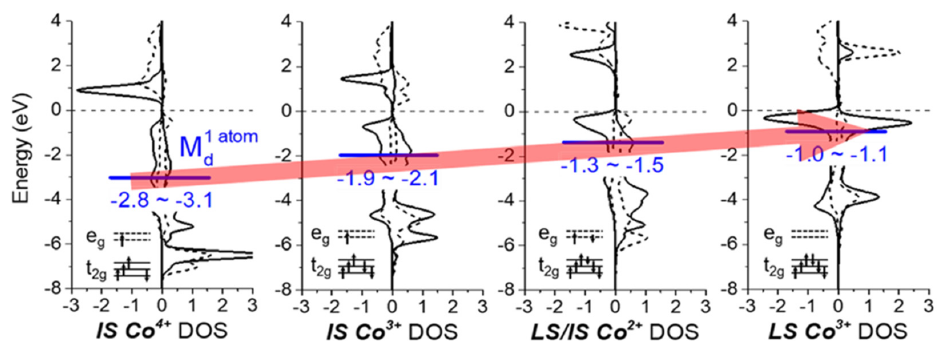
Figure 5. From left to right, intermediate spin states (IS) of Co 4+ , IS of Co 3+ , a crossover of Co 2+ between intermediate- and low-spin states (IS/LS), and LS of Co 3+ . Positive values indicate majority spin states, while negative values indicate minority spin states. The black dashed line represents the e g orbital, and the solid black line represents the t 2 g orbital of the Co 3d orbital. The solid blue line indicates the calculated d-band center ( M d ) position. The dashed horizontal line appears at the Fermi level, with occupied states at negative energies and unoccupied states at positive energies. Reproduced with permission from ref. [52], Copyright 2020, American Chemical Society.